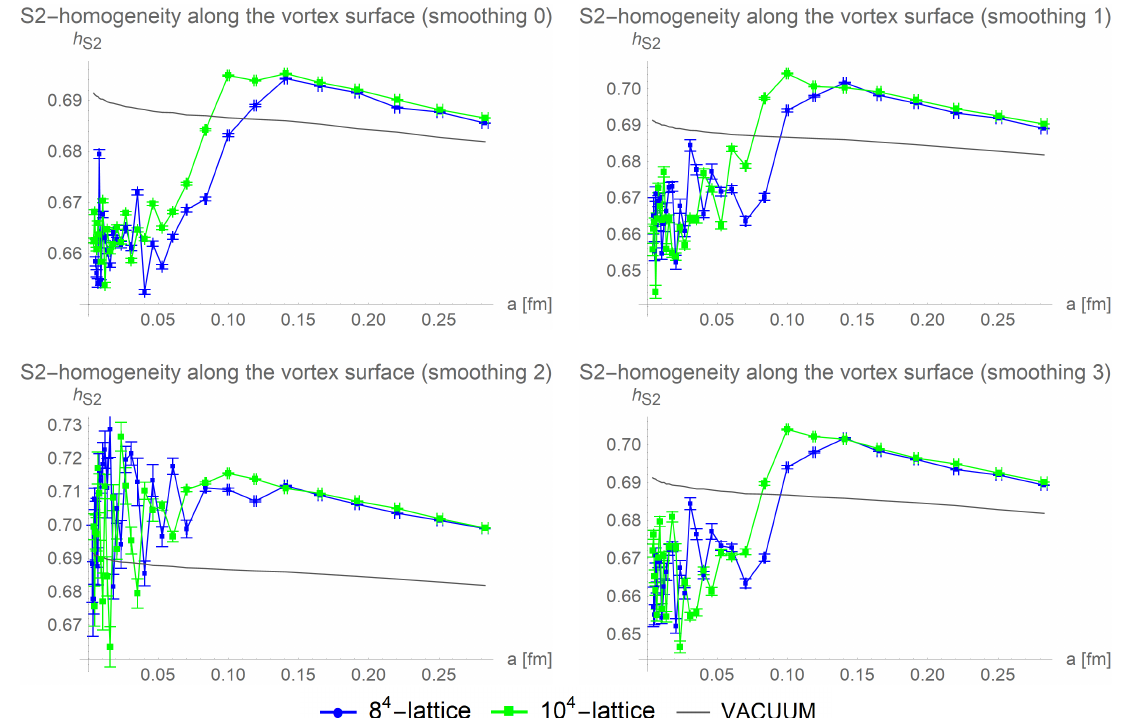
Figure 16. Averaged over 100 configurations, the S2-homogeneity along the vortex surface is compared for different lattice sizes and smoothing procedures after five cooling steps. All smoothing procedures result in a vortex more homogeneous than the vacuum.